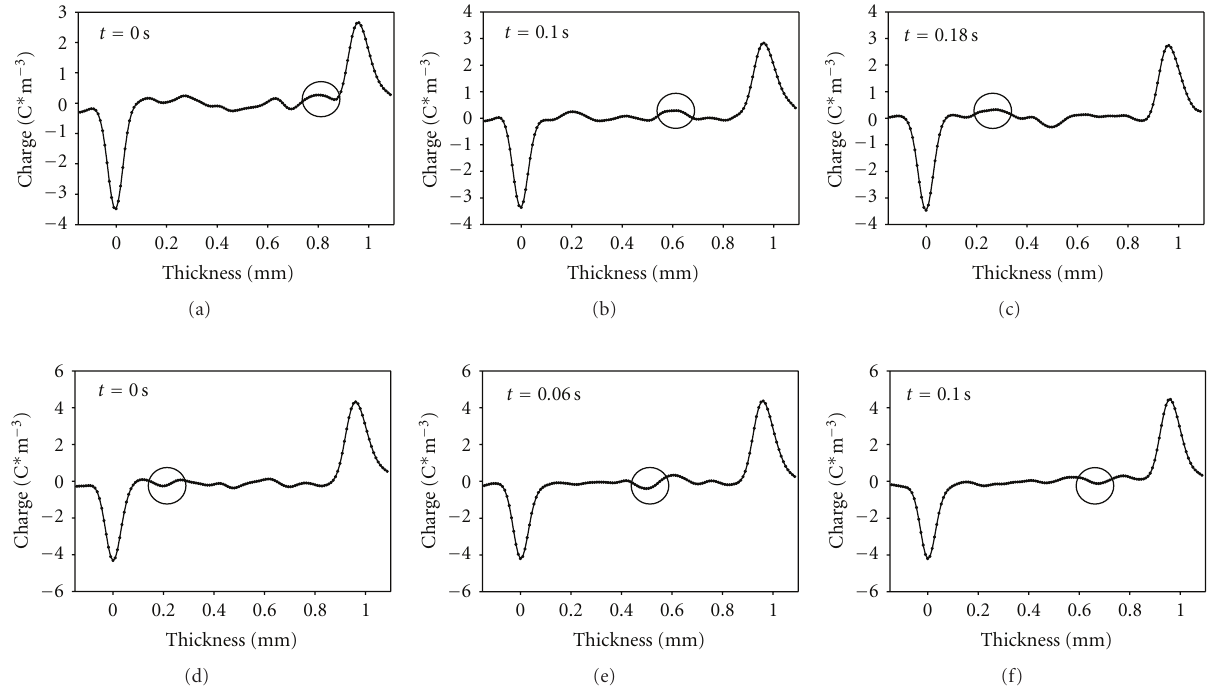
Figure 6: Evolution of charge profiles in specimen no. 10 under an electrical field of 10kV/mm and temperature of 70 ◦ C for a positive charge pulse (a)–(c) and a negative charge pulse